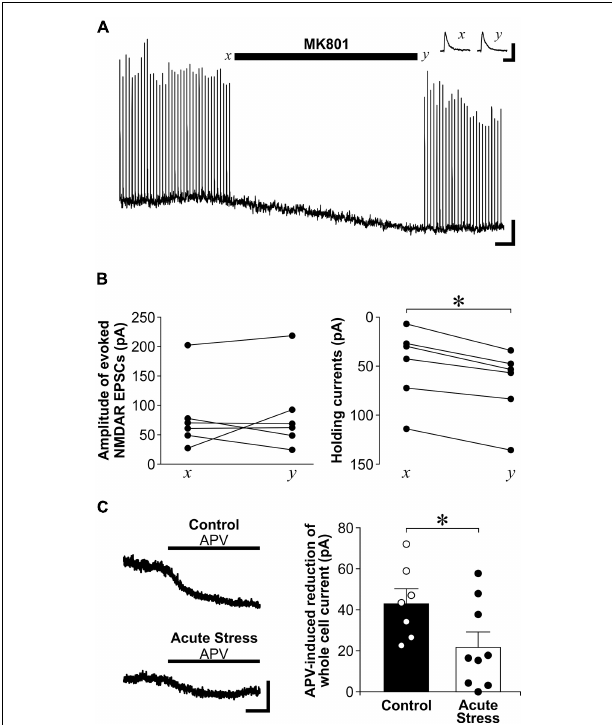
FIGURE 3 | Acute stress reduces exNMDAR currents mediated by ambient glutamate. (A) Representative trace shows the effect of MK801 on evoked NMDAR-mediated EPSCs and whole-cell holding currents recorded from a CA1 neuron. Stimulations for evoking EPSCs were stopped at x and during MK801 application. MK801 reduced whole-cell holding currents. However, the amplitudes of evoked NMDAR-mediated EPSCs were not affected when stimulation was resumed at time y . The reduction of EPSC amplitude near the end of the trace was likely due to residual levels of MK801 in the recording chamber. Scale bar = 40 pA, 1 min. Inset: traces of sNMDAR before ( x ) and after ( y ) MK801 application. Scale bar = 200 pA, 200 ms. (B) Line plots show changes in evoked NMDAR-mediated EPSCs ( left ; 6 recordings, 3 rats) and whole-cell holding currents ( right ; 6 recordings, 3 rats) before ( x ) and after MK801 application ( y ). ∗ p < 0.05, paired Student’s t -test; current at time x vs. time y . (C) Left: Representative traces of APV (50 µ M) -induced blockade of whole-cell current of CA1 neurons in brain slices from control or acutely stressed rats. Scale bar = 40 pA, 1 min. Right: Histograms of the APV-induced blockade of whole-cell currents recorded from hippocampal slices of control (7 recordings, 3 rats) or acutely stressed rats (9 recordings, 4 rats). Mean ± SEM. ∗ p < 0.05, Student’s t